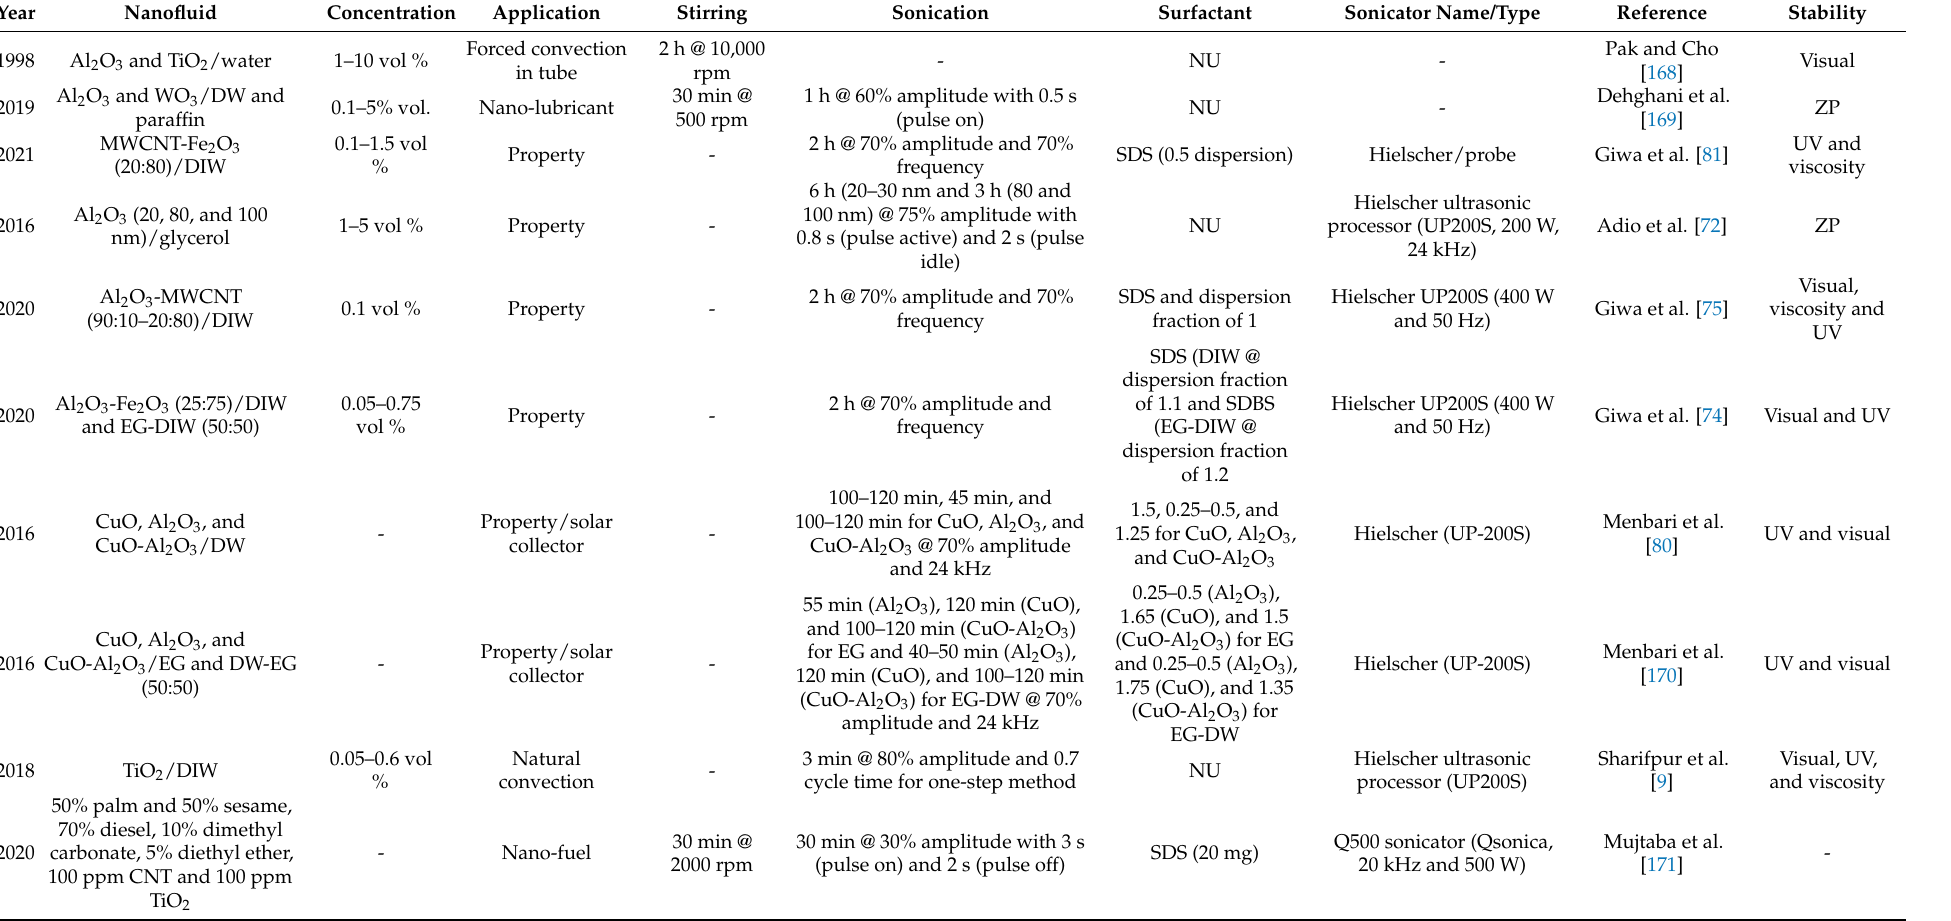
Table 2. Future possible paradigm shift for nanofluid